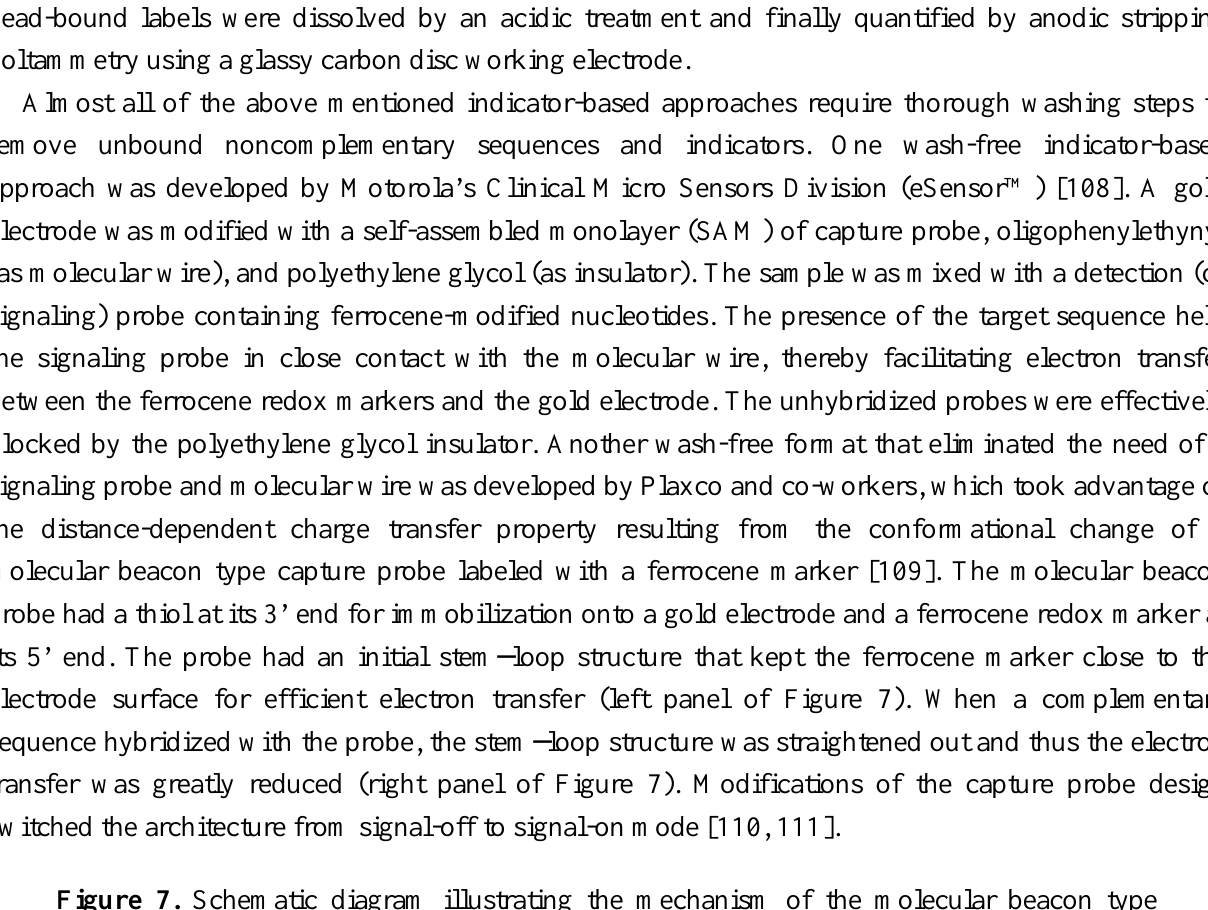
Figure 7. Schematic diagram illustrating the mechanism of the molecular beacon type electrochemical DNA sensor. From Fan et al ., Proc. Natl, Acad. Sci. USA , 2003 , 100